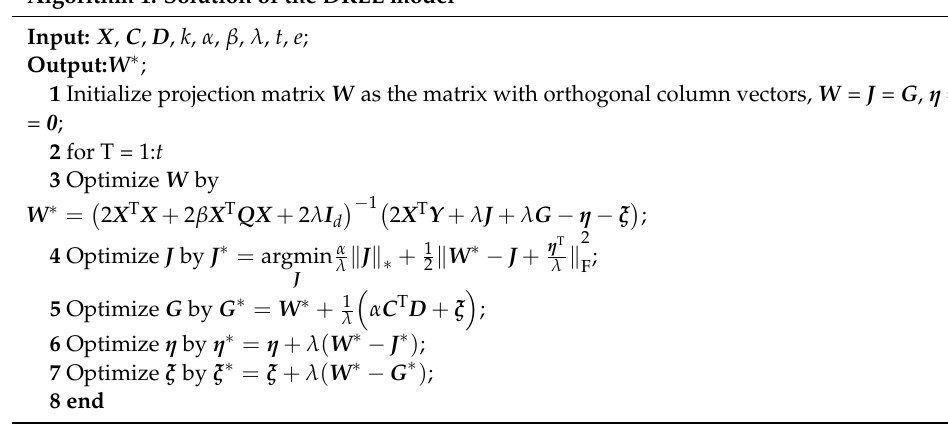
Algorithm 1. Solution of the DRLL